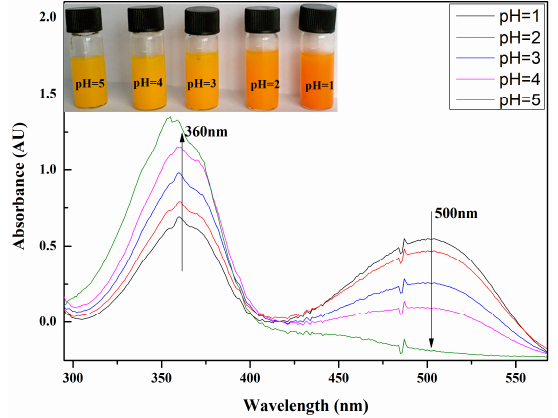
Figure 7. PMMAZO-grafted CNCs aqueous solutions (c = 0.2 g · L − 1 ) at different pH, UV–VIS spectra of the MMAZO solution at different pH.